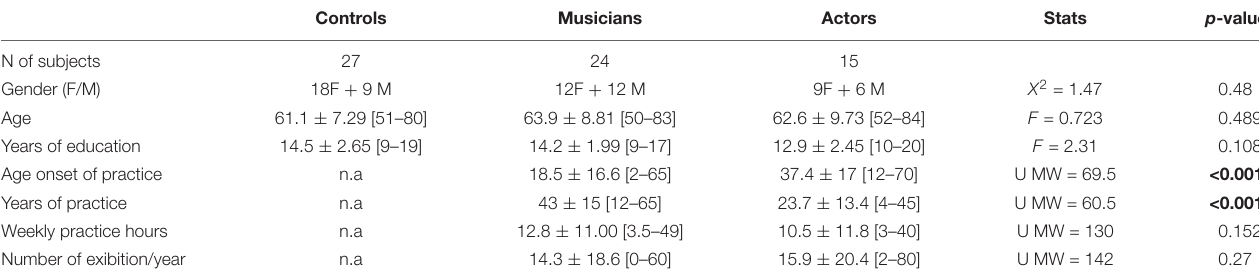
Controls Musicians